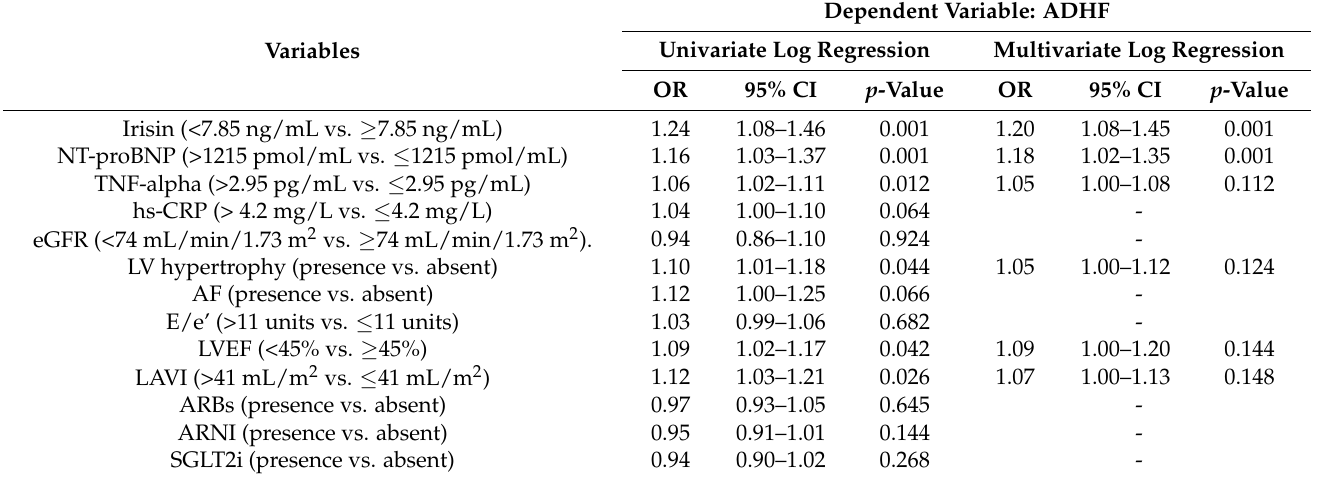
Table 3. Predictors for ADHF in T2DM patients with chronic HF. The results of the univariate and multivariate log regression analysis.